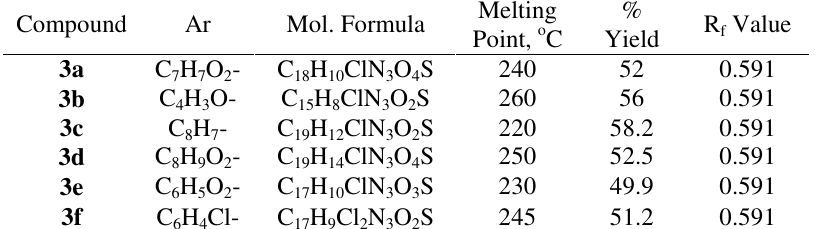
Table 1. Physical and analytical data of compound